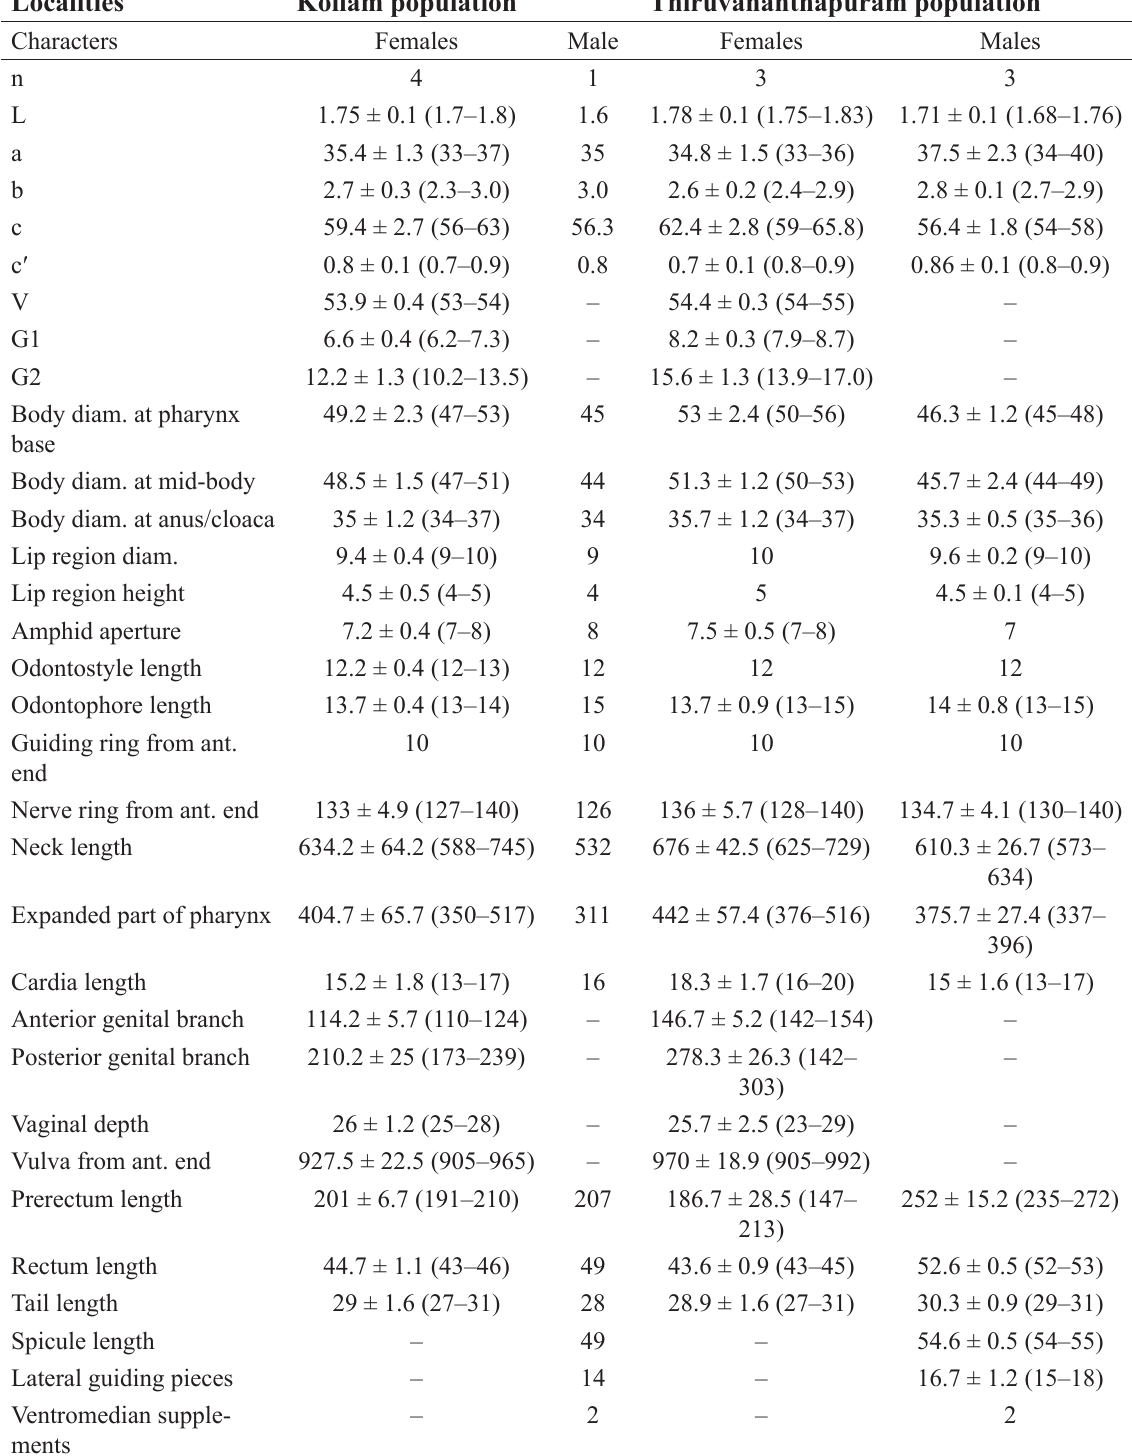
Table 4. Measurements of Axonchium vallum Ahmad & Jairajpuri, 1982. All measurements in µm except L in mm, and in the form: mean ± s.d.